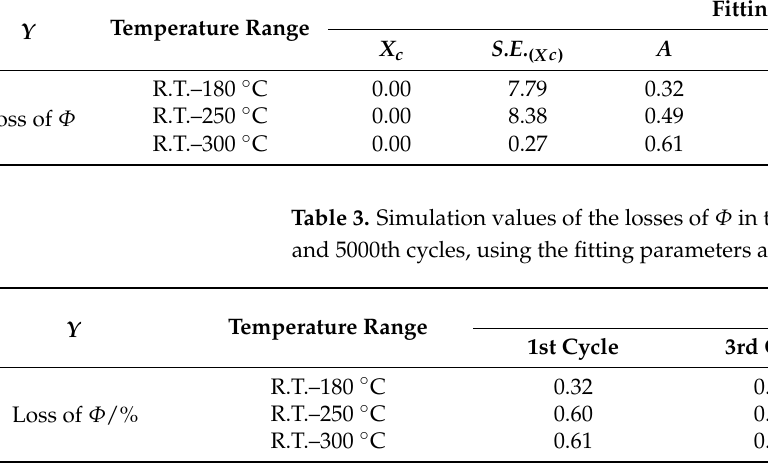
Figure 3. ( a ) Demagnetization curves, ( b ) B r , ( c ) H cj , ( d ) ( BH ) max , and ( e ) H k /H cj of the samples after the 125th cycle at different upper limit temperatures.